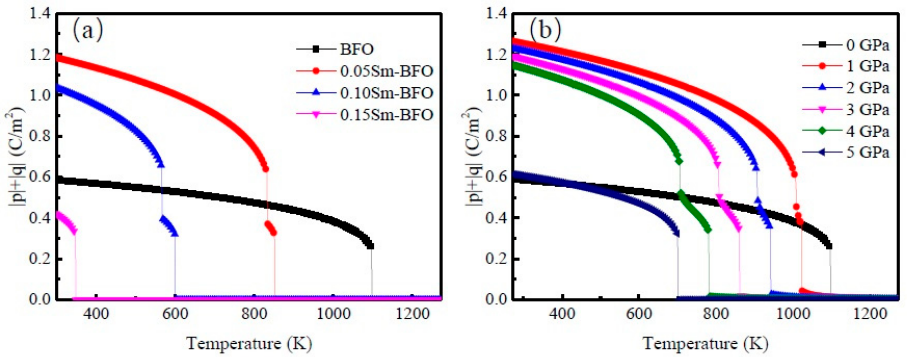
Figure 2. The total polarization with ( a ) Sm compositions and ( b ) hydrostatic pressures as a function of temperature.